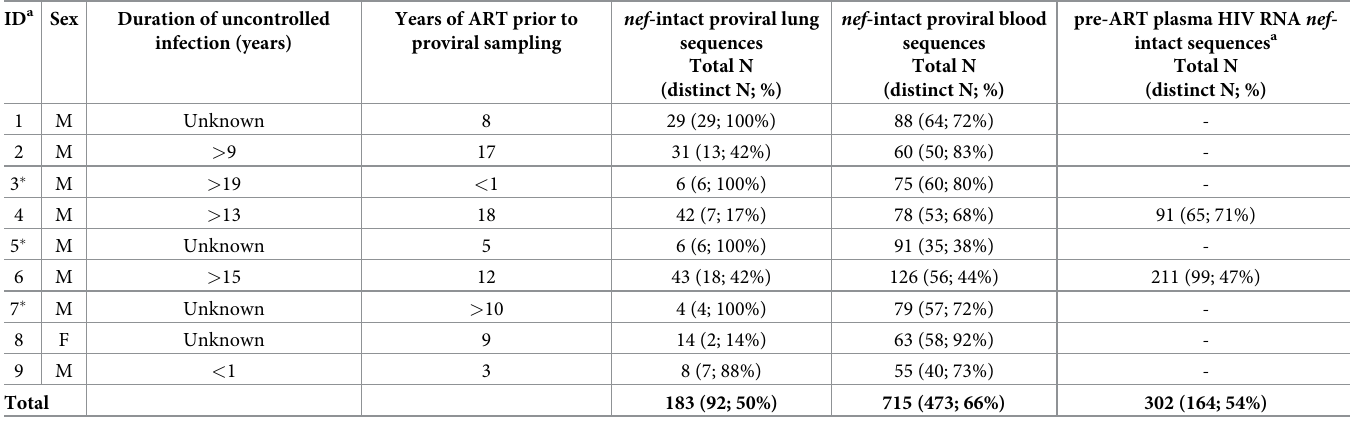
Table 1. Participant information and HIV sampling details.